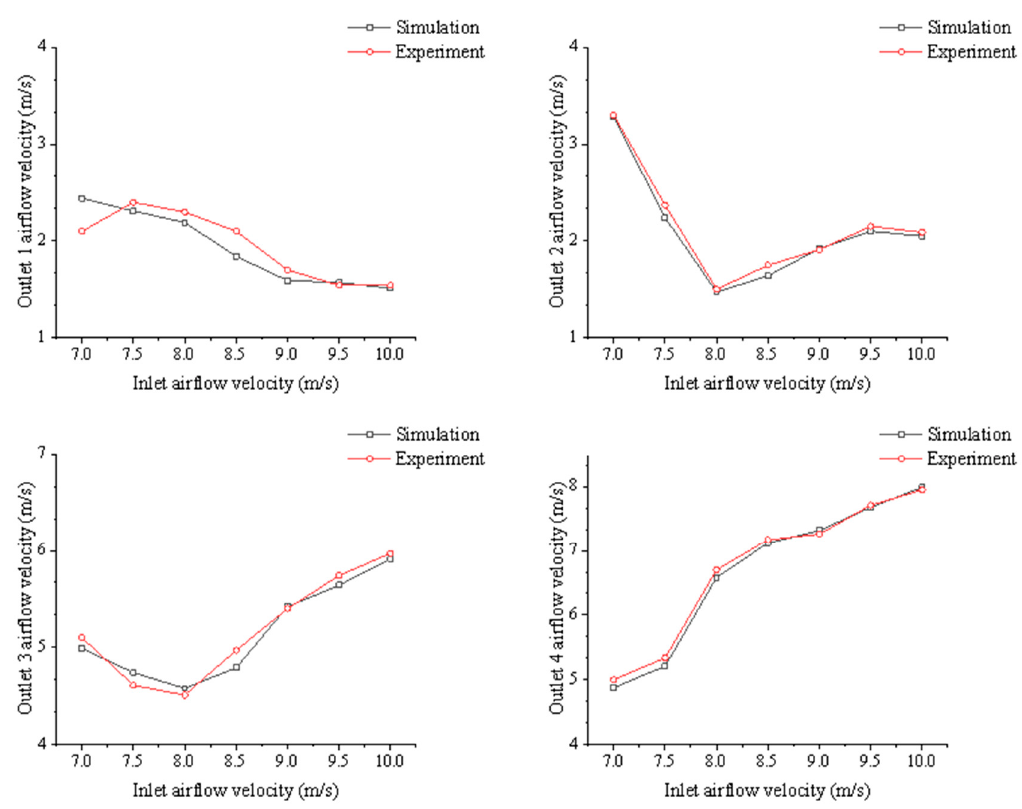
Figure 10. Comparison between experiment and simulation results.